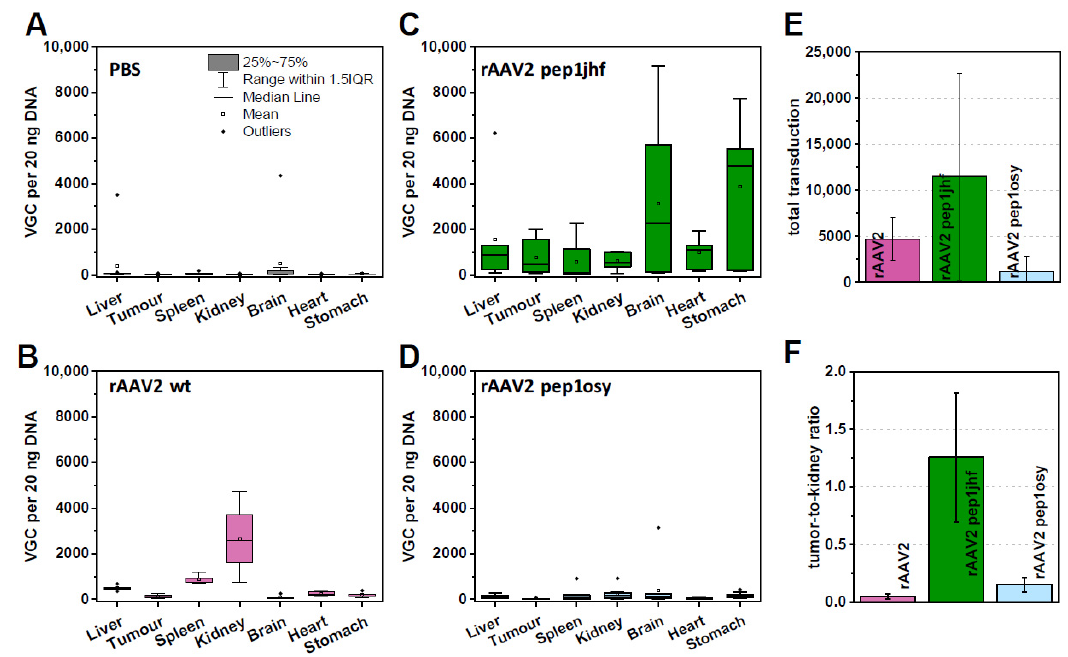
Figure 5. Chorioallantoic membrane (CAM) assays analyzing rAAV variants with respect to viral uptake in organs and tumor xenografts. A431 tumors were grown on CAM for five days prior to injection of rAAV2 variants with 1 × 10 11 viral particle per egg. After 48 h incubation organs were extracted from chicken embryos, DNA was isolated, and vector genome copy (VGC) of 20 ng total DNA quantified by qPCR analyses. Box-whisker diagrams represent indicated replicates for each sample: ( A ) PBS, 10 replicates; ( B ) rAAV2 wt, 5 replicates; ( C ) rAAV2 pep1jhf, 7 replicates; ( D ) rAAV2 pep1osy, 11 replicates. ( E ) Total VGC uptake of each rAAV variant was calculated by summarizing the VGC per 20 ng DNA for each organ. ( F ) Tumor–kidney ratio was calculated from mean copy number / 20 ng DNA for each organ. Error bars represent mean ± SEM for